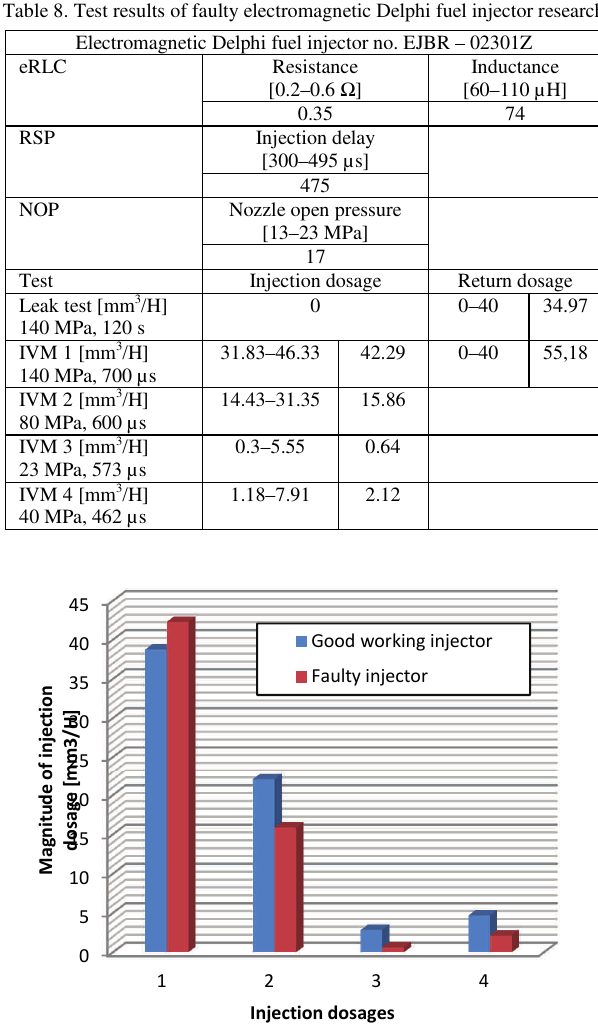
Fig. 15. Injection dosages comparison between faultless and faulty elec- tromagnetic Delphi fuel injector 1 – full load dosage, 2 – medium